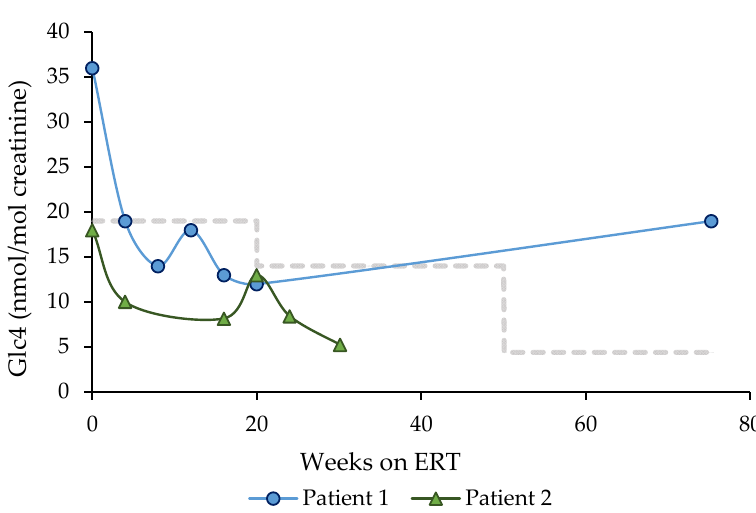
Figure 4. Evolution of urinary glucose tetra-saccharide (Glc4) levels after ERT initiation in Patient 1 (started ERT < 3 months of age) (blue line), and Patient 2 (started ERT < 1 month of age) (green line). The horizontal dashed line indicates the upper limit of the control range (19 mmol/mol creatinine, age 0 to 6 months; 14.0 mmol/mol creatinine, age 6 to 12 months; 4.4 mmol/mol creatinine, age > 12 months of age [12]). Enzyme replacement therapy (ERT).